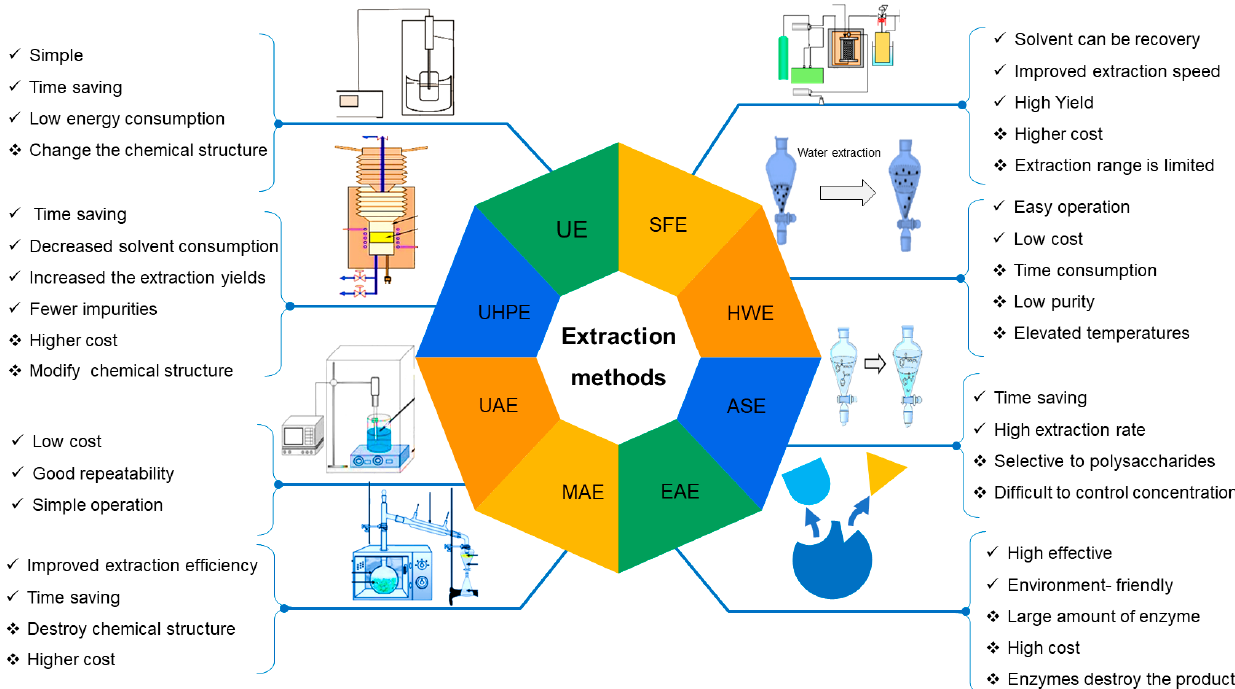
Figure 1. Classifications of polysaccharides.